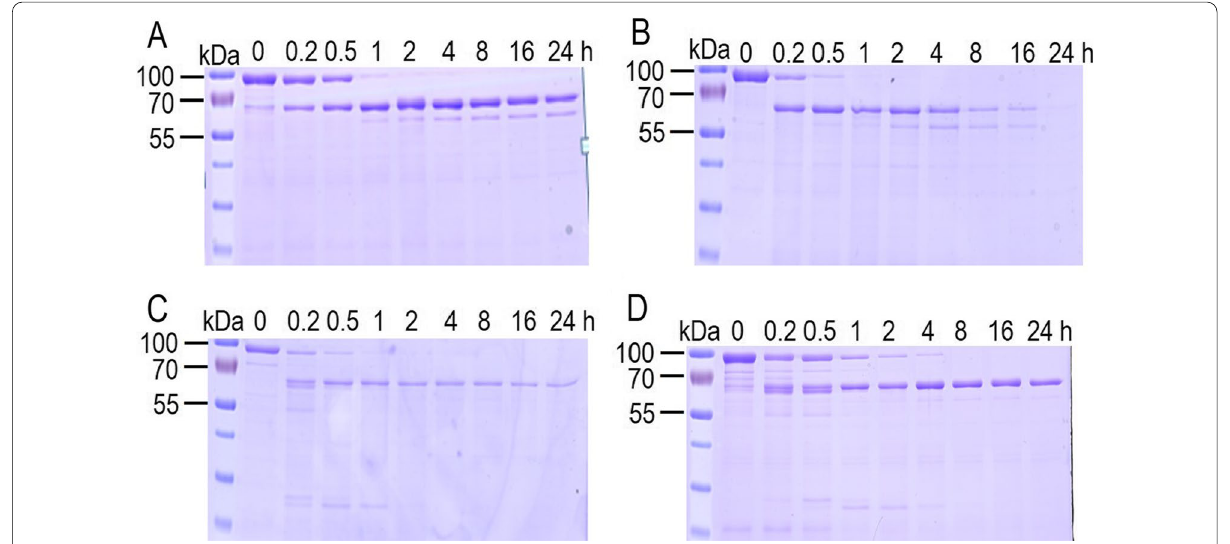
Fig. 4 Time course of proteolytic processing of wild‑type Vip3Aa ( A ), P591A ( B ), P605A ( C ) and P779A ( D ) by S. exigua midgut juice